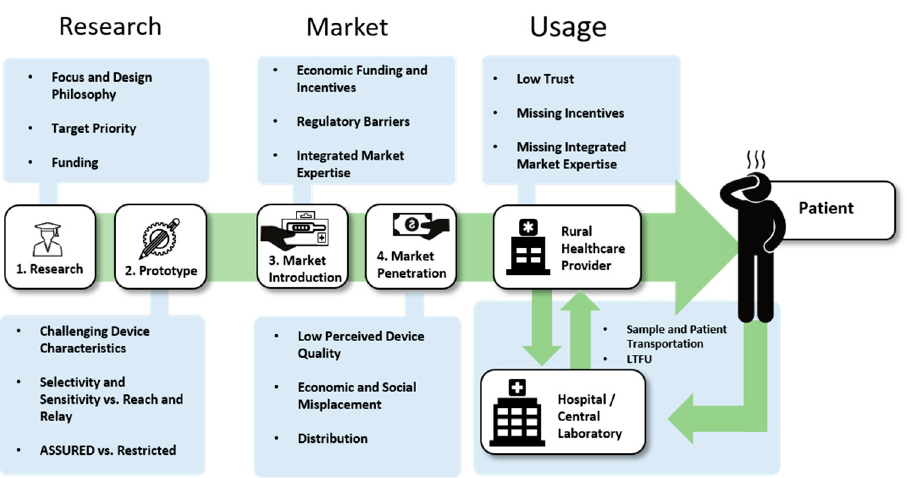
Figure 4. Identified Problems along the value chain.